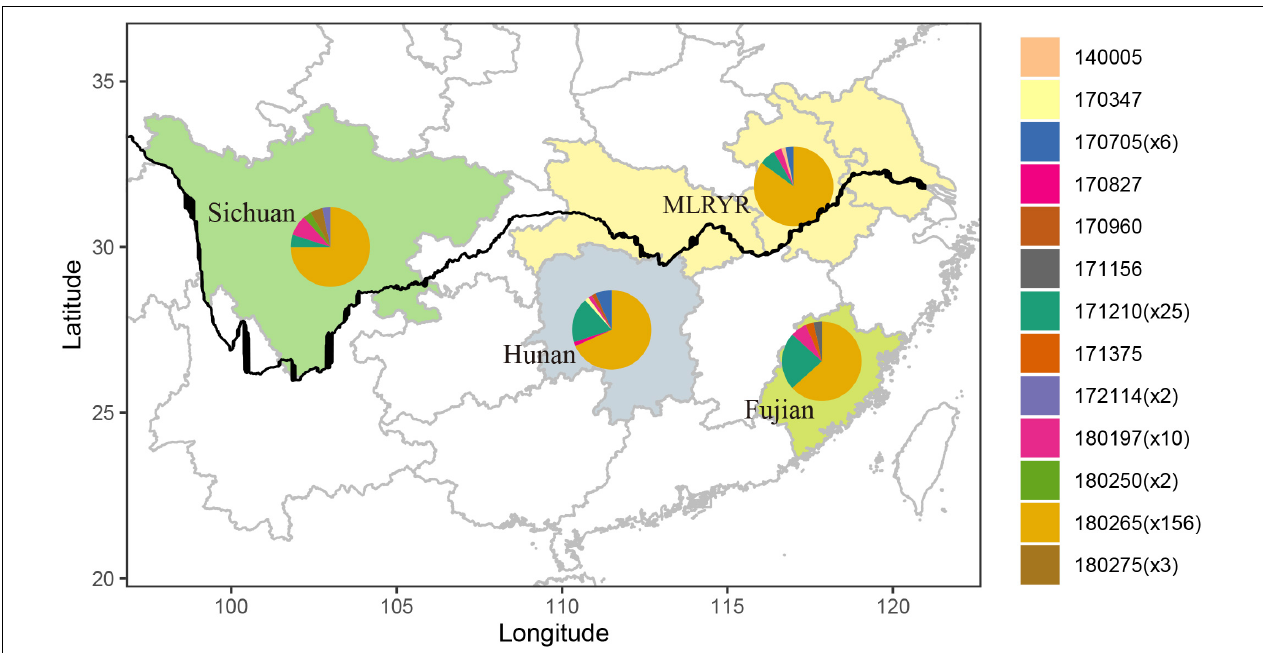
FIGURE 3 | Map of four ecological regions indicating the distribution of haplotypes composed by non-intronic regions from 210 F. asiaticum isolates. The figure in parenthesis means the number of specific